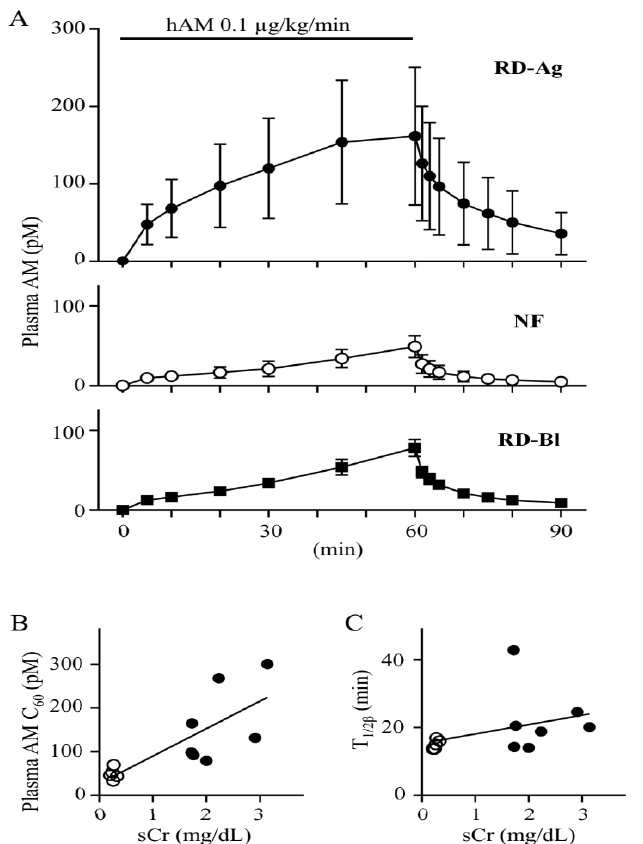
Figure 1. Plasma concentration of human AM in rats with mercury chloride-induced renal dysfunc- tion increases independently of renal excretory function. ( A ) Plasma concentration vs time curve of human adrenomedullin (AM) during 60-min continuous intravenous infusion (0.1 µg/kg/min) in rats with renal dysfunction and normal rats. Closed circles, renal dysfunction rats induced by mercury chloride treatment (RD-Ag, top, n = 7); opened circles, normal renal function rats (NF, middle, n = 5); closed squares, renal dysfunction rats with bilateral renal blood flow blockage (RD-Bl, bottom, n = 3). ( B ) A positive correlation ( R 2 = 0.6149, p < 0.01) between plasma concentration of human adrenomedullin at 60 min for intravenous infusion (AM C 60 ) and serum creatinine (sCr) in RD-Ag and NF rats. ( C ) Lack of correlation between plasma elimination half-life (T 1/2 β ) and serum creatinine (sCr) in RD-Ag and NF rats. Bars represent means ± SD.